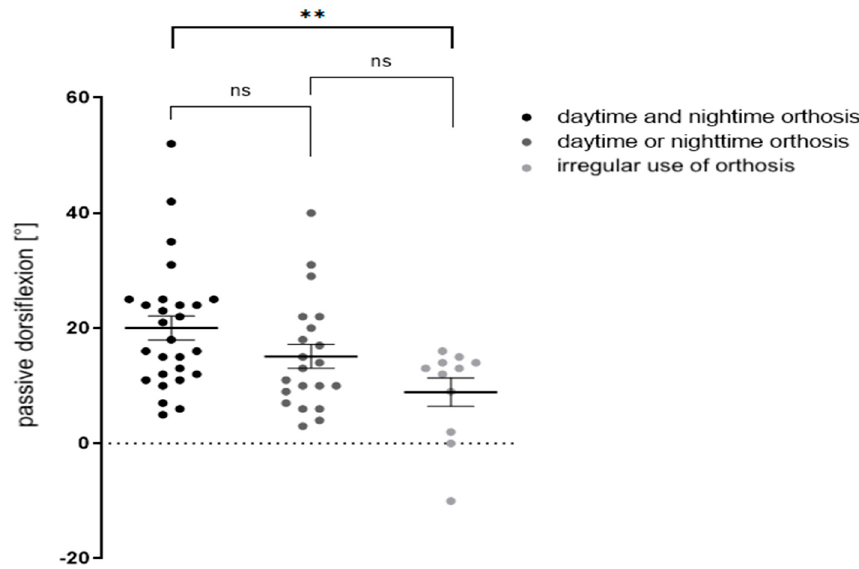
Figure 4. Impact of regular use of orthotic devices on passive ankle dorsiflexion at follow-up (** p < 0.05).